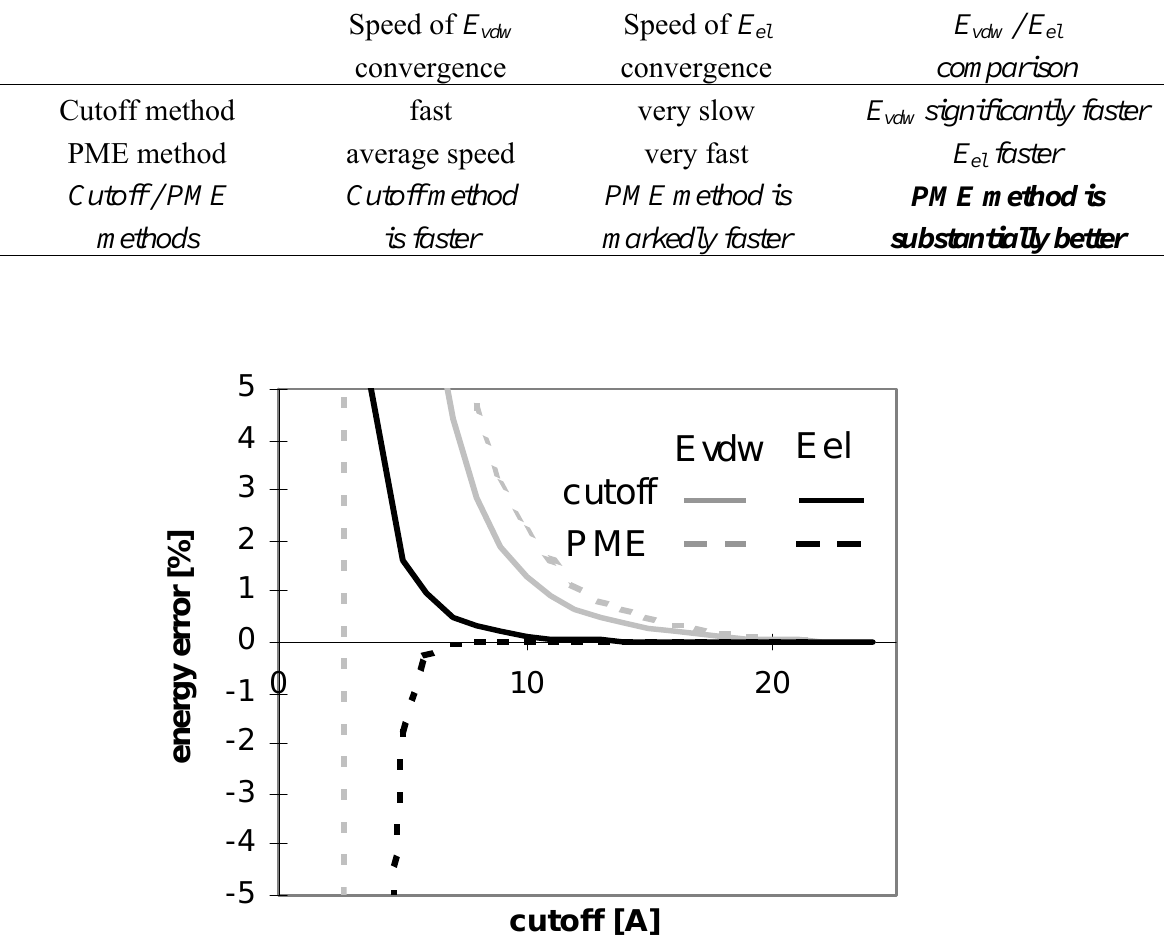
Figure 8. Dependency of energy error on cutoff for oligonucleotide O4 in explicit solvent. For description of energy error see Figure